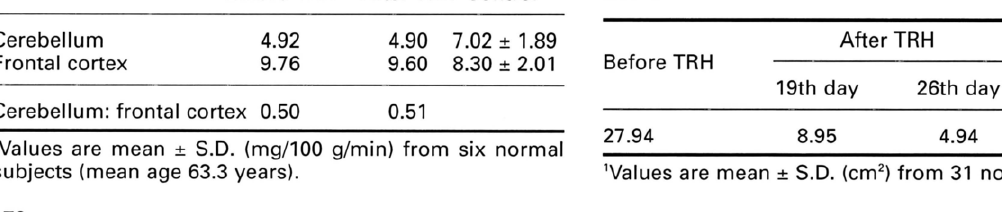
measured by stabilography before and after TRH treat